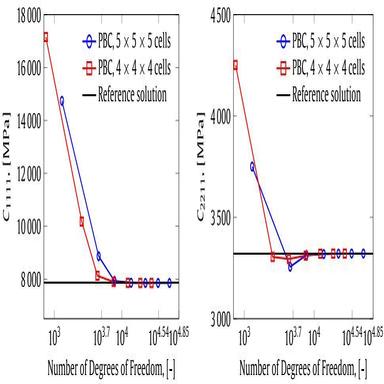
Convergence studies of two entries into the elasticity tensor C1111, C2211.